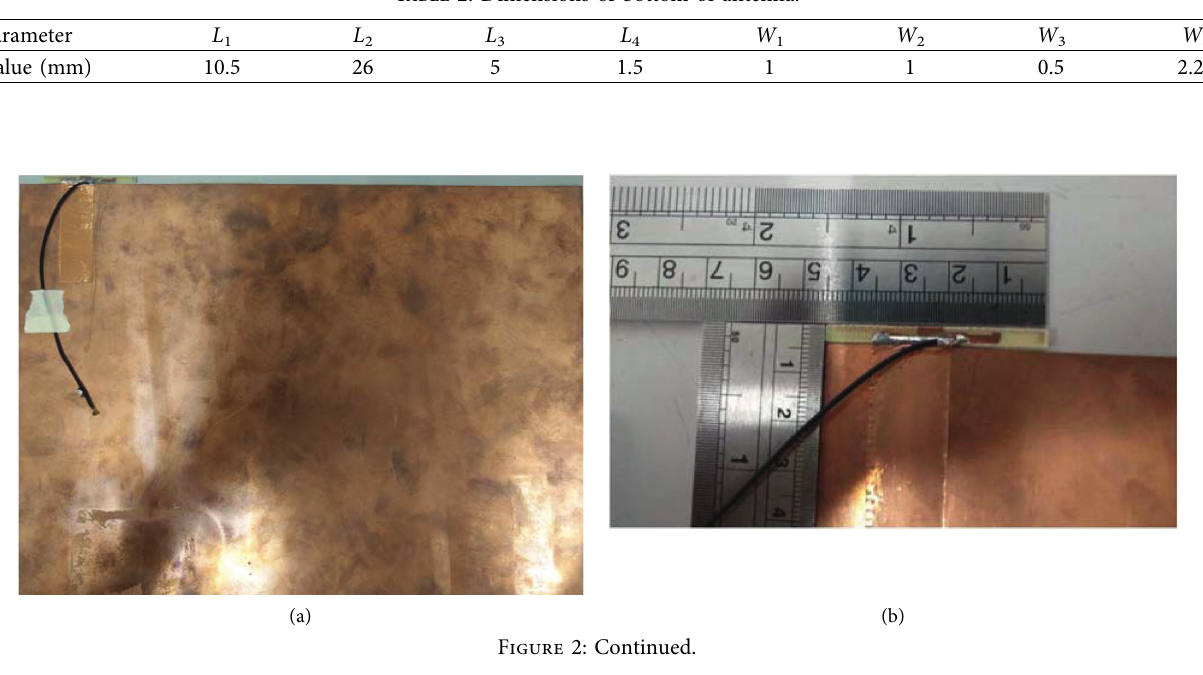
Table 2: Dimensions of bottom of antenna.